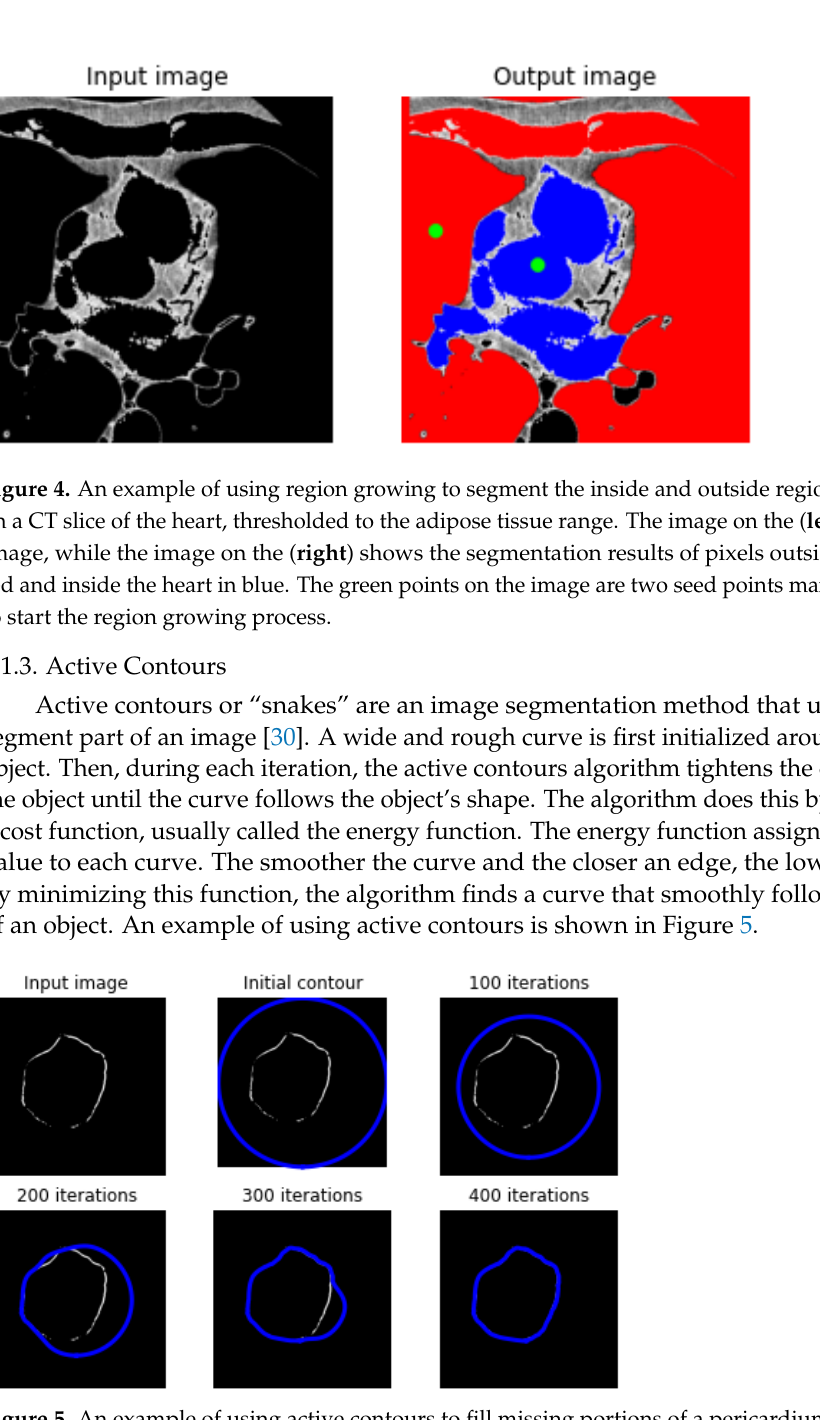
Figure 5. An example of using active contours to fill missing portions of a pericardium line obtained by thresholding a CT scan, shown in white. The contour is shown in blue, initially a perfect circle around the image. In each iteration, the contour is deformed to better fit the